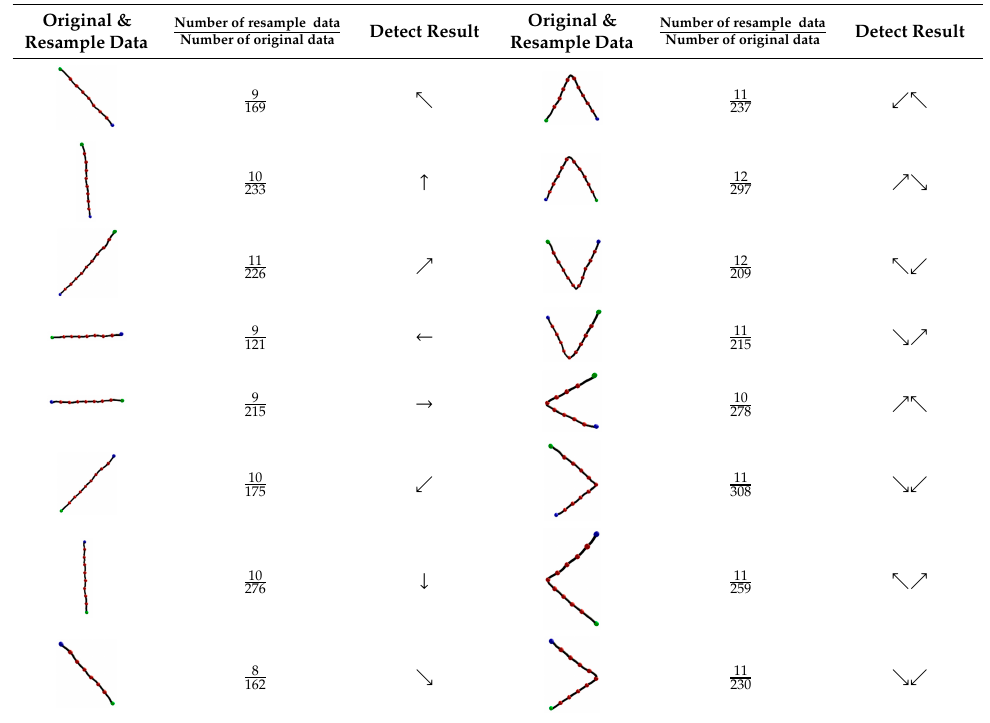
Table 5. Recognition result at over-sampling.